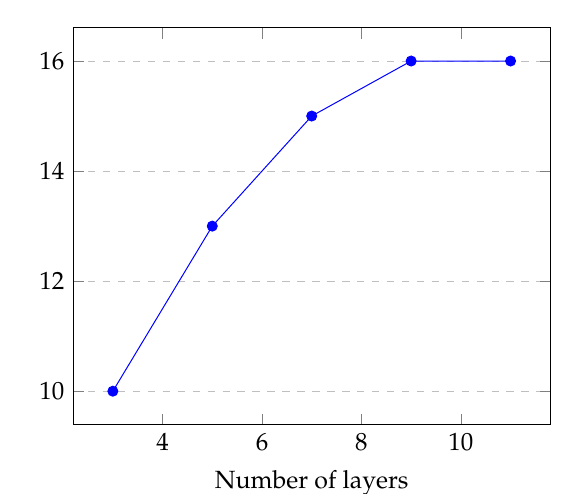
Figure 2. The relationship between the number of neural network layers and the reduced Hasse interval.